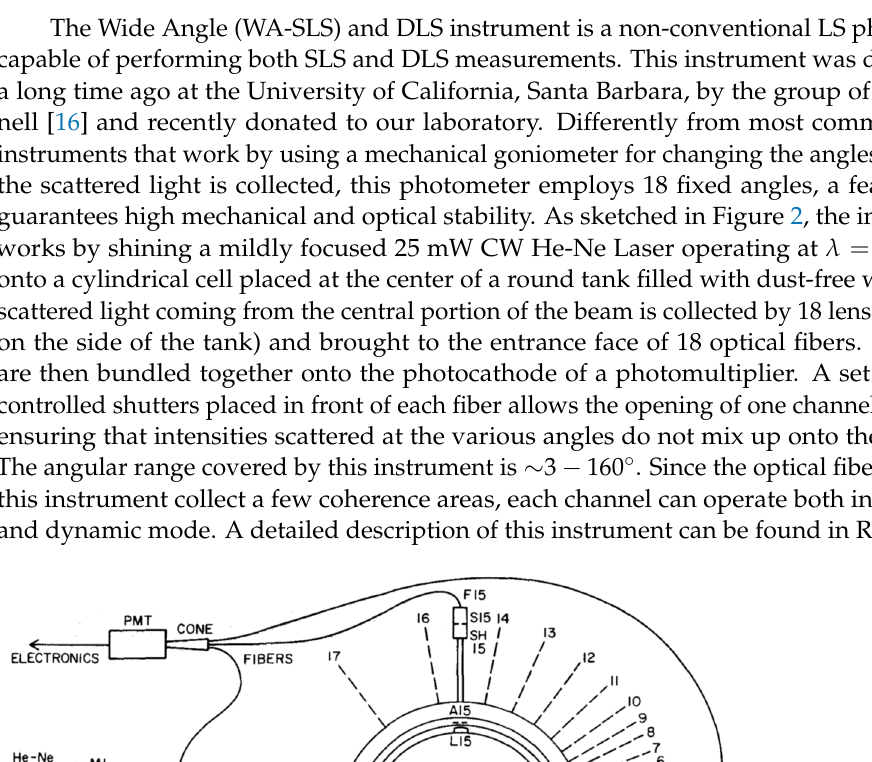
Figure 1. ( a ) Schematic diagram of the LALS + MWT setup. ( b ) Schematic diagram of the annular array sensor used for the LA-SLS measurements. Figure adapted from Ref. [14].